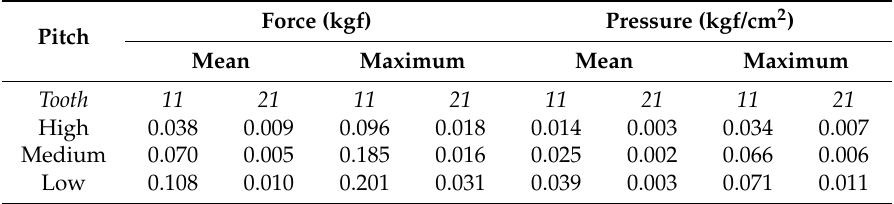
Table 1. Table with the mean and maximum forces and pressures applied by the saxophone to tooth 11 (right upper central incisor) and 21 (left upper central incisor) with different pitches. Force (kgf) Pressure (kgf/cm 2 ) Pitch Mean